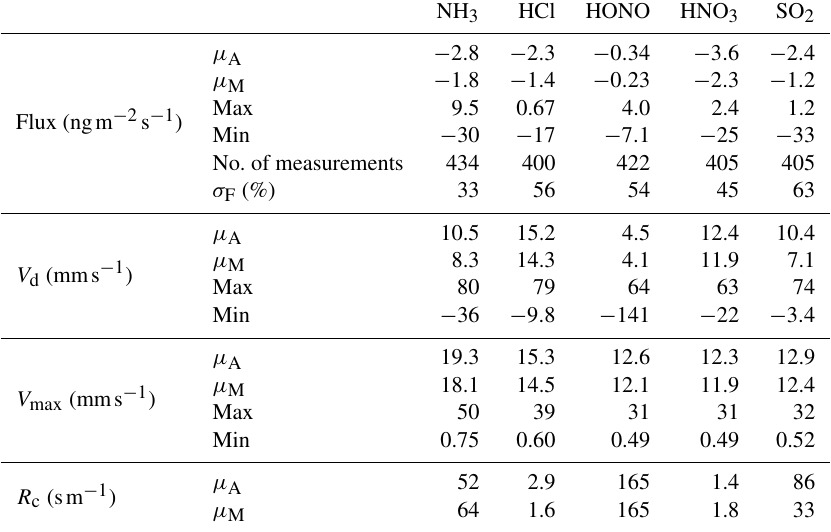
Table 2. Mean ( µ A ), median ( µ M ), maximum and minimum values of post-roughness sub-layer correction for fluxes, deposition velocities ( V d ), theoretical maximum deposition velocities ( V max ) and canopy resistances ( R c ) for the inorganic trace gases measured during Amazon Tall Tower Observatory campaign. The number of fluxes calculated is quoted as number of measurements, and the median error in flux measurements as a percentage of flux values for each individual trace gas species ( σ F ) is included as part of the statistical summary for fluxes.